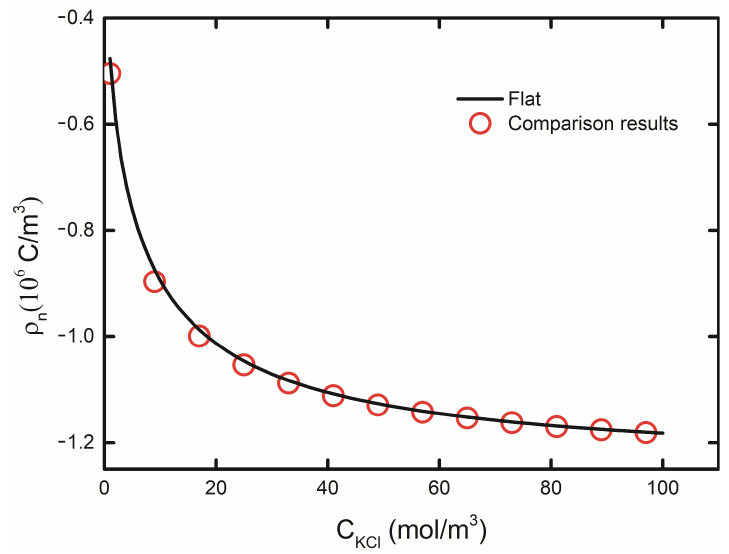
Figure 2. The fluctuating curve of brush layer charge density depending on background salt solution concentration of the plate, shown as the black solid line, and the red dot represents the analysis result in [1], pH = 7.